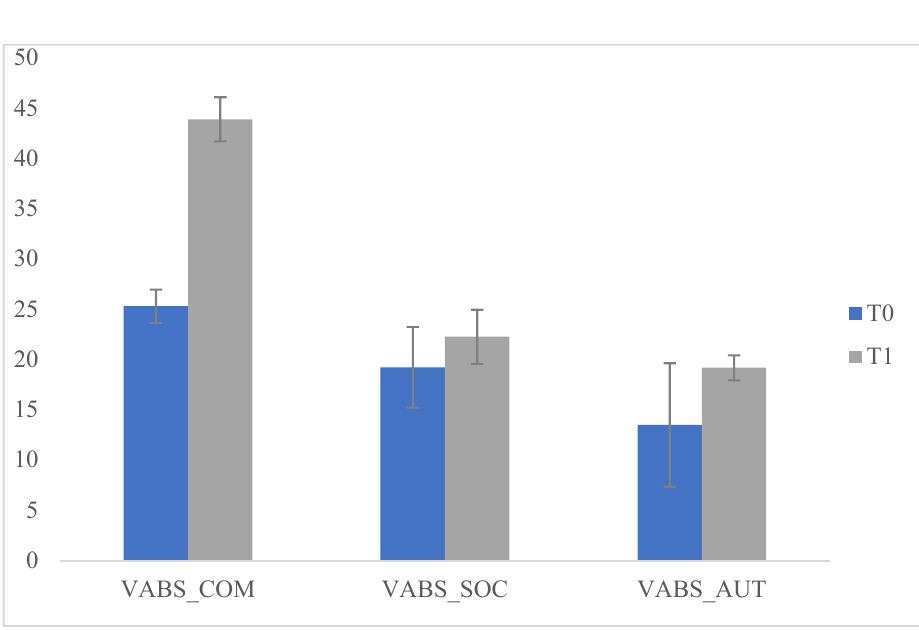
Figure 1. Comparisons of Vineland Adaptive Behavior Scales (VABS), T0 and T1 .